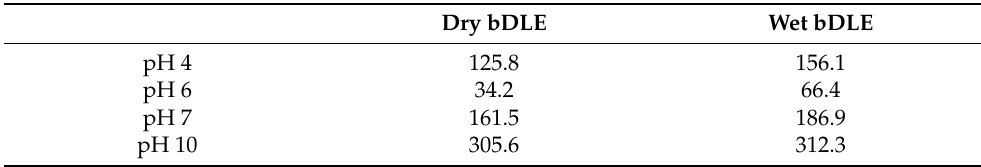
Figure 5. Zeta potential values. Zeta potential values of wet (black) and dry (red) bDLE at 4, 6, 7, and 10 pH values as determined by dynamic light scattering (DLS) in a Zetasizer ZS90-Nano (Malvern Instruments, Malvern, UK). Table 2. Zeta potential values of wet and dry bDLE.